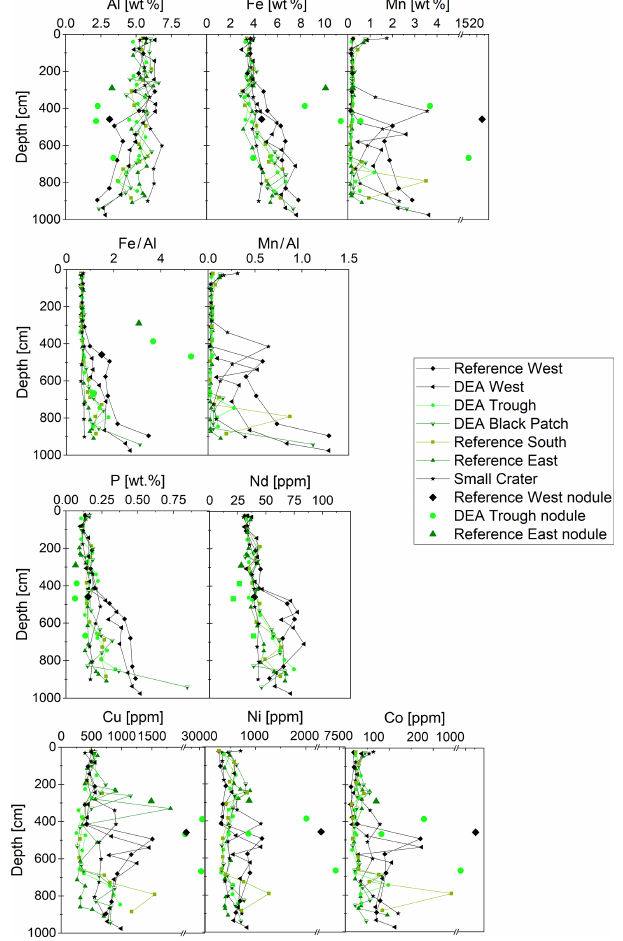
Figure 6. Solid-phase Al, Fe, Mn, P, Nd, Cu, Ni, and Co concentra- tions in the sediment cores, including those of the buried nodules at Reference West at 458cm; at DEA Trough at 387, 468, and 667cm; and at Reference East at 290cm. Nd is shown as a representative of the REY. Fe / Al and Mn / Al ratios (for the latter no data for the nodules are shown) are also displayed as depth profiles, focusing on the Fe and Mn enrichment in relation to continental sources